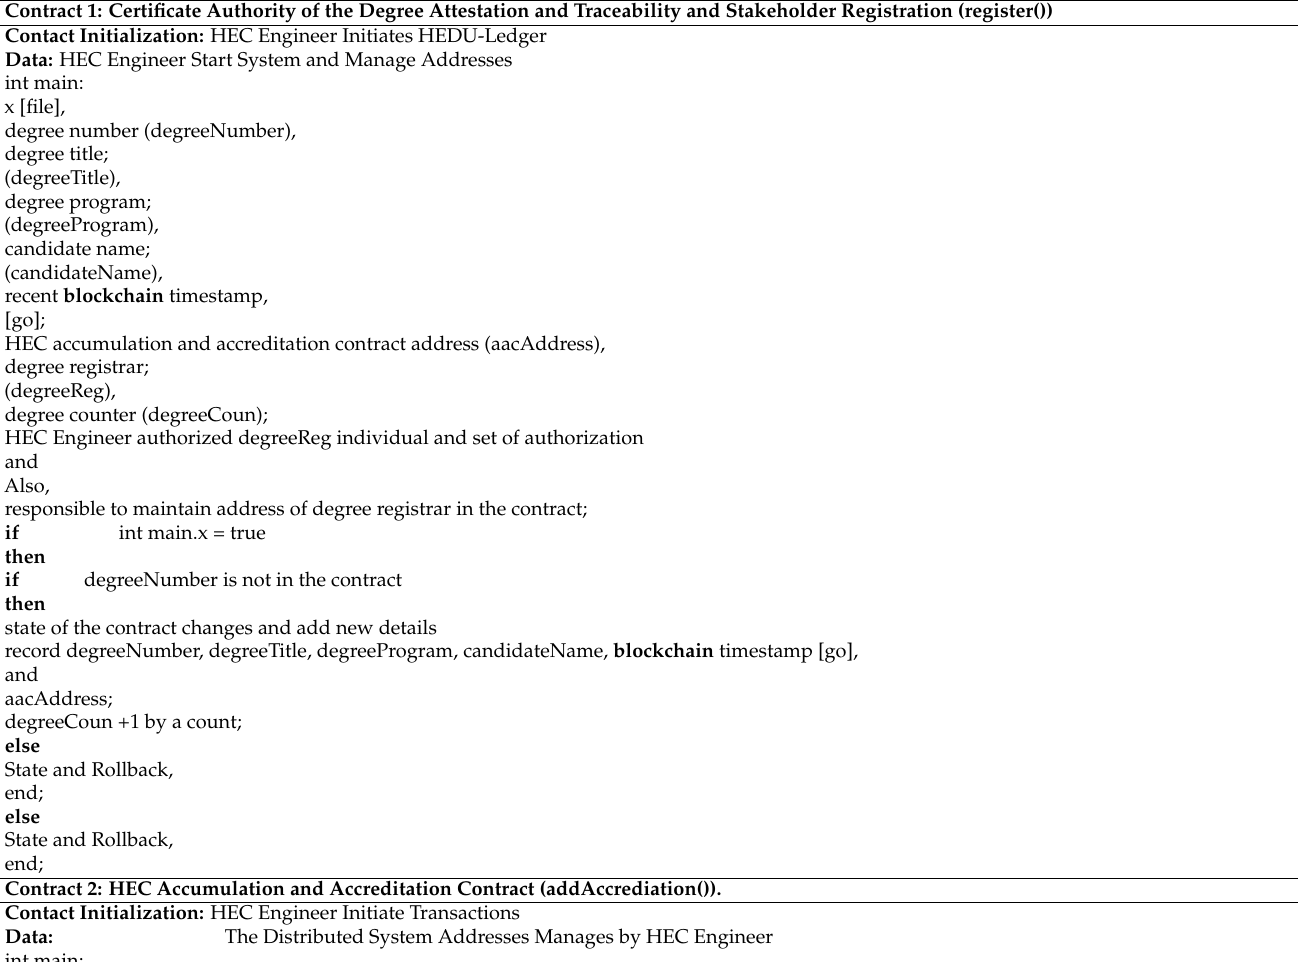
Table A1. Implementation of Smart